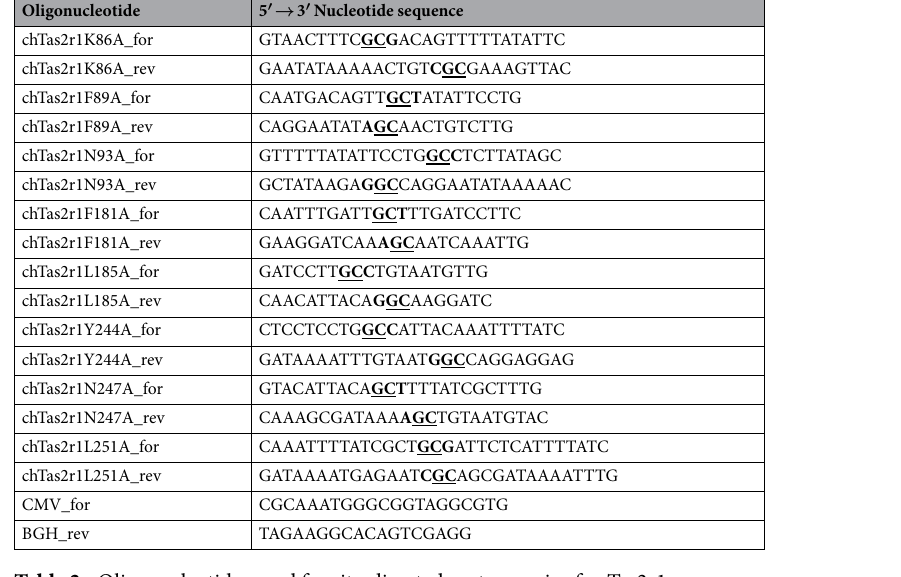
Table 2. Oligonucleotides used for site-directed mutagenesis of